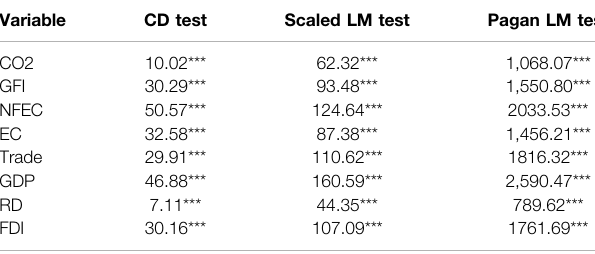
TABLE 4 | Cointegration test